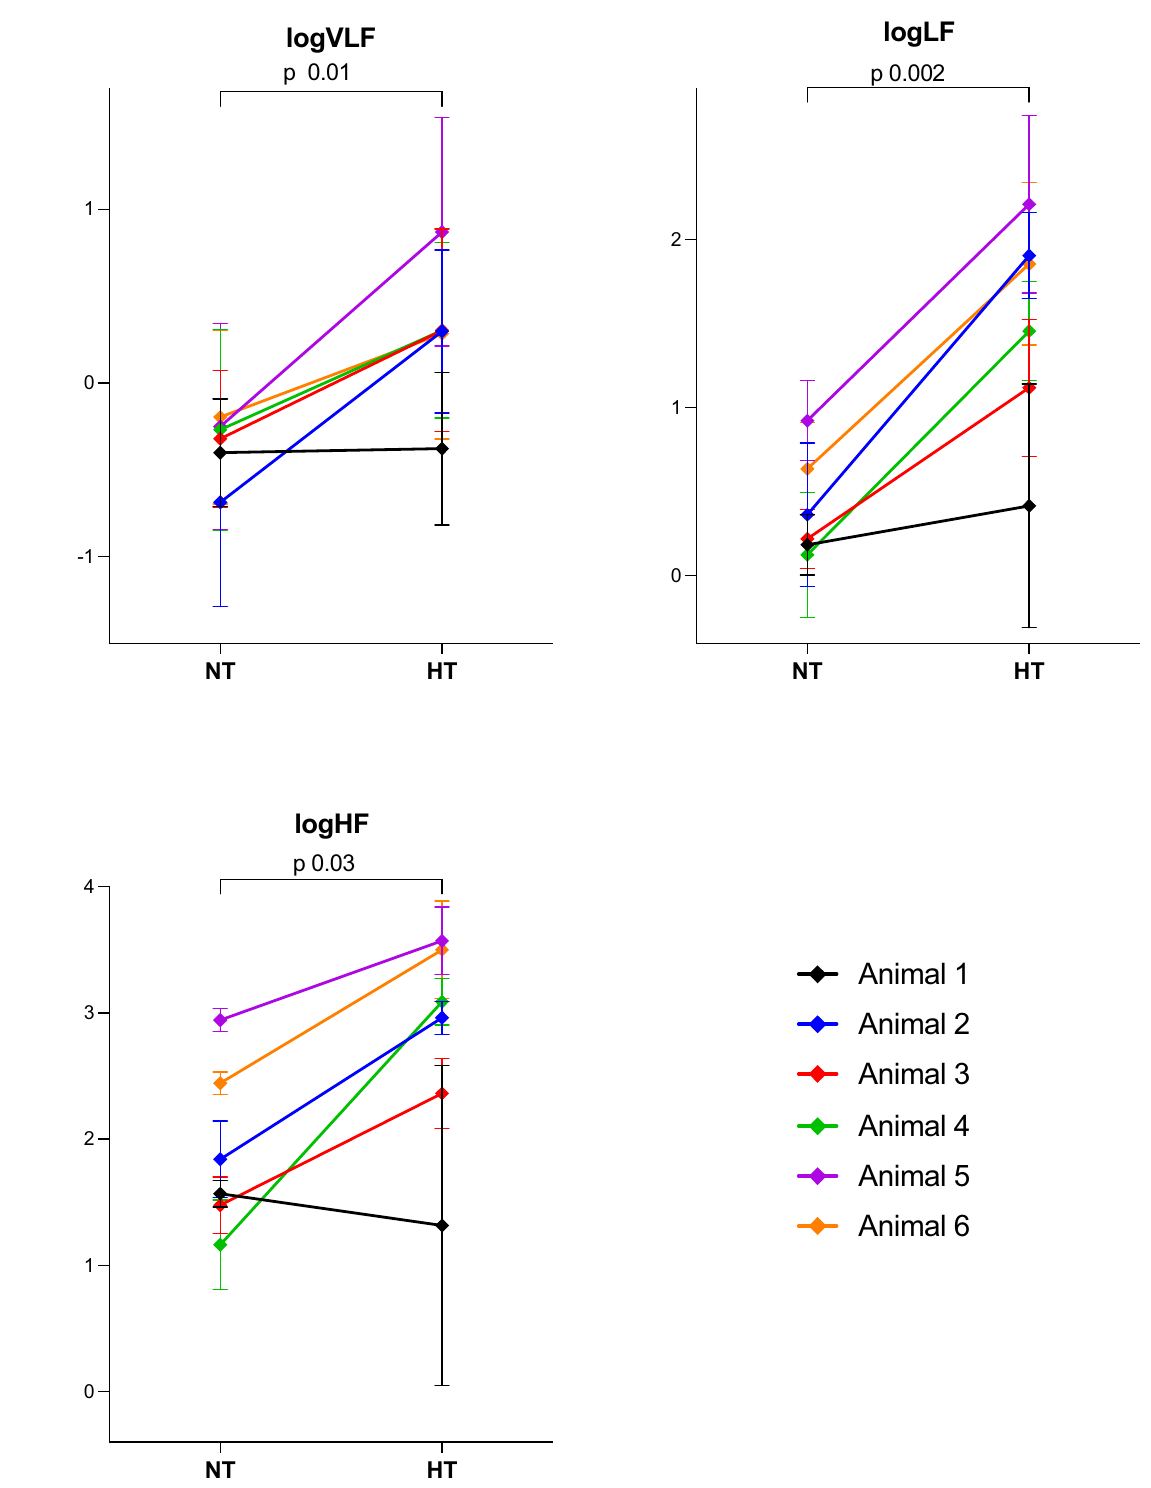
Figure 2. HRV frequency domain variables in six healthy, anaesthetised, newborn piglets exposed to 3 h of normothermia (38.5–39.5 °C) and 3 h of hypothermia (33.5–34.0 °C). Data are presented as mean with SD of 3 h of normothermia (NT) and mean with SD of 3 h of hypothermia (HT). P -value comparing NT with HT with paired t-test. NT: Normothermia; HT: Hypothermia; SDNN: Standard deviation of normal-to-normal interval; RMSSD: Root mean square of successive differences; logVLF: log-transformed power in the very low frequencies; logLF: log-transformed power in the low frequencies; logHF: log-transformed power in the high frequencies; HR: heart